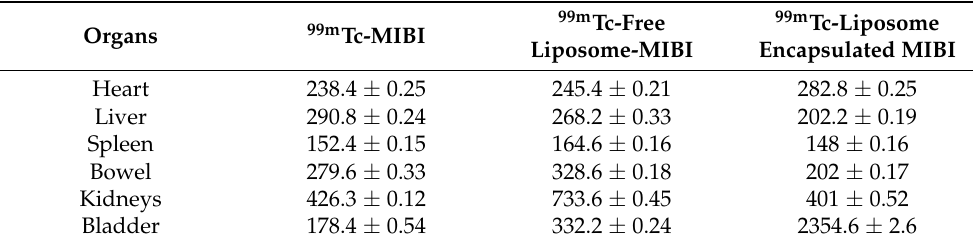
Table 2. Biodistribution of 99m Tc-MIBI compared to that of 99m Tc-liposomal agents in different organs at 1 h